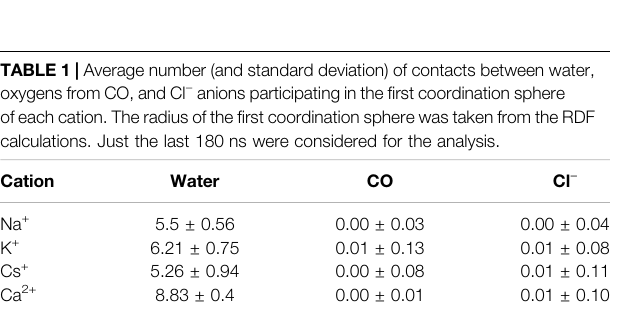
FIGURE 7 | Details of the fi rst sphere of coordination of con fi ned Na + (A) and Ca 2+ (B) .